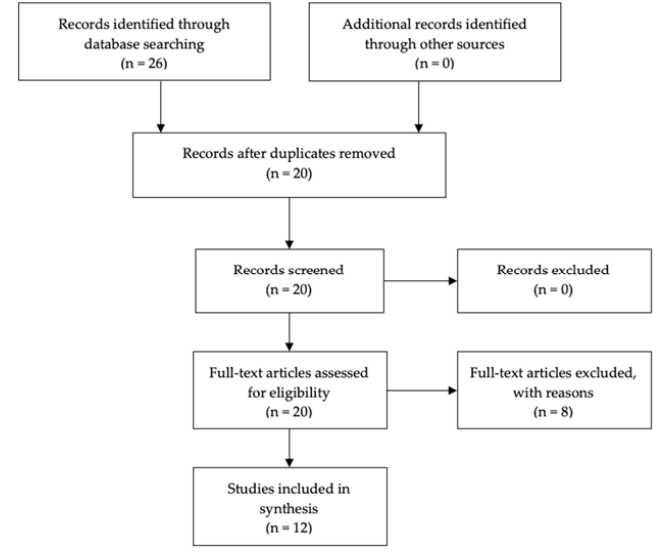
Figure 1. Flow diagram of the article selection process based on Preferred Reporting Items for Systematic Reviews and Meta ‐ Analyses (PRISMA) guidelines [62].